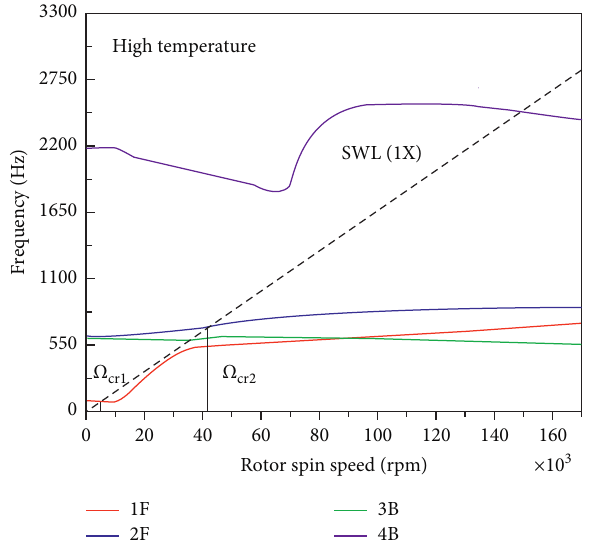
Figure 19: Effect of temperature on the Campbell diagram.